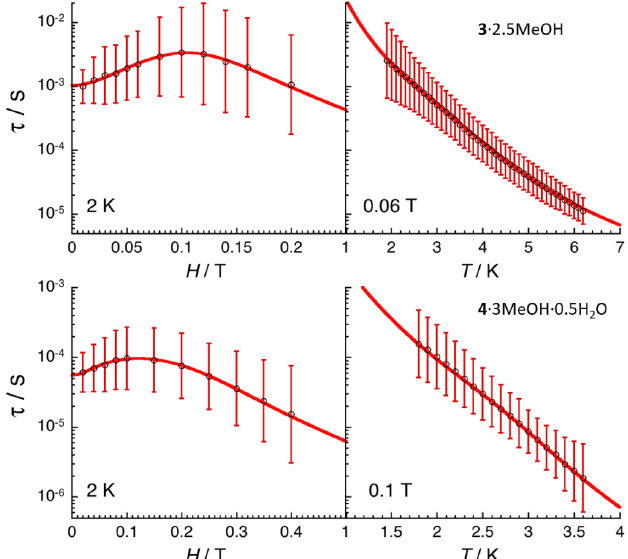
Figure 9. Frequency dependence of the real, in-phase ( χ ′ , top) and imaginary, out-of-phase ( χ ", bottom) components of the ac susceptibility under an external dc field of 1000 Oe (0.1 T) at the indicated temperatures for complex 4 ∙3MeOH∙0.5H 2 O. Solid lines are visual guides on the left plots, while they show the generalized Debye fit of the ac data on the right. The combination of all these frequency dependent ac data (Figures 8 and 9, Supplementary Figures S10 and S13) and their fit to the generalized Debye model [80] allows the determination of the field and temperature dependence of the relaxation time , τ, and its estimated standard deviation (ESD) [81], which quantifies the broadness of the relaxation time distribution. As shown in Figure 10,